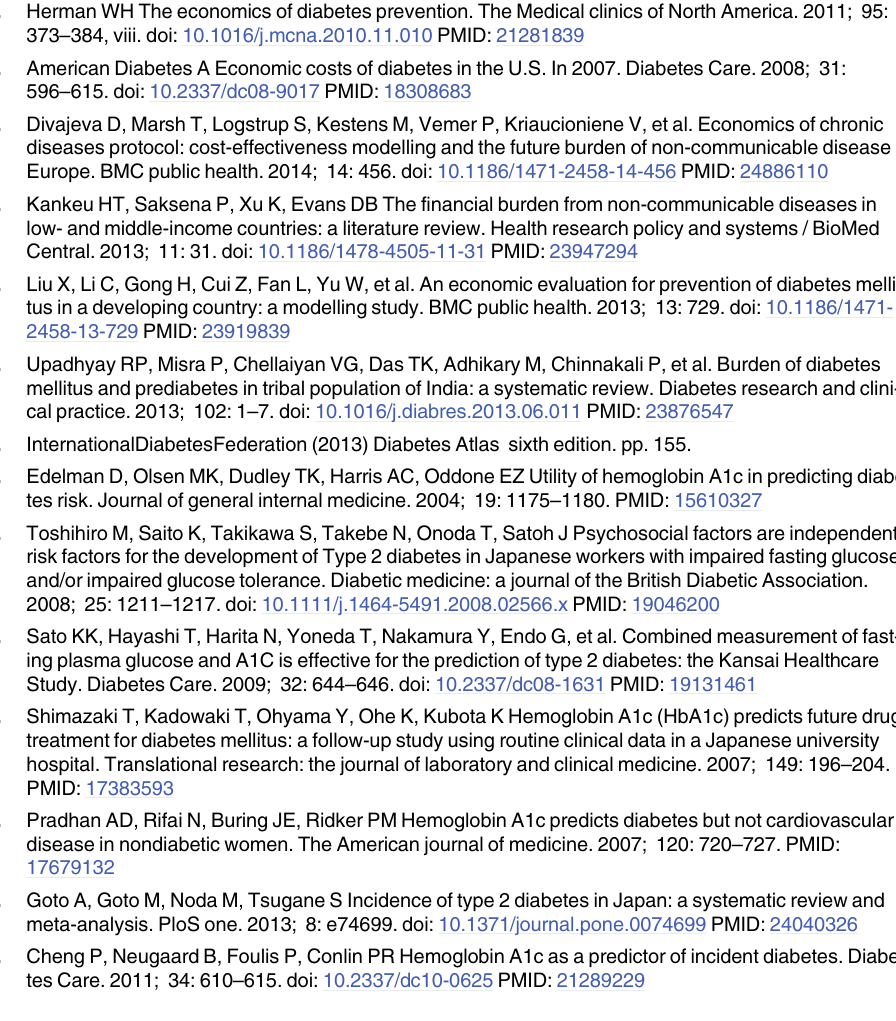
S2 Table. The distribution of baseline HbA